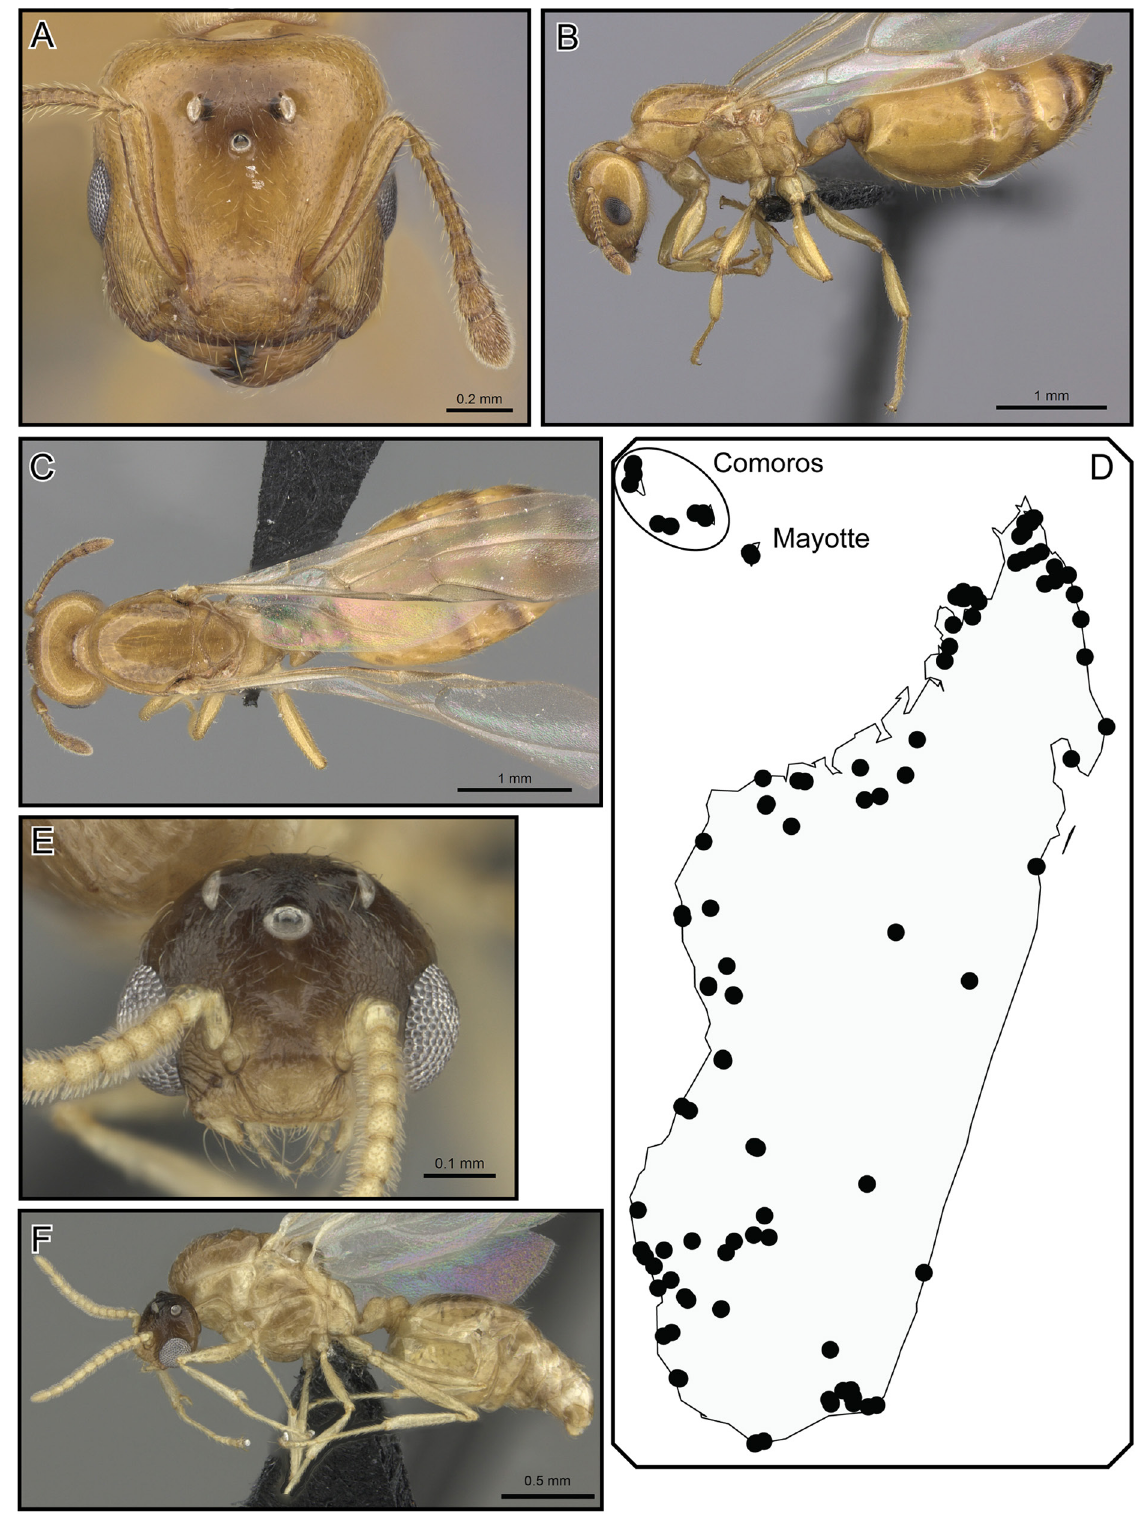
Fig. 16. Crematogaster maina sp. nov., queen, male and distribution. A-C. Queen